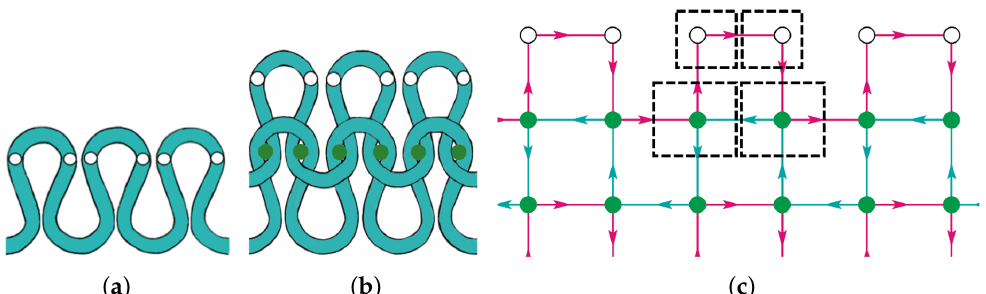
Figure 3. A Purl stitch is created by pulling a loop of yarn through a loop held from the previous row from front to back. ( a ) Row of loops. ( b ) Purl stitches produced from another row of stitches. ( c ) Topological representation. Note that an ACN produced by a Purl stitch is colored green, as compared to the gray disks of Knit-stitch-produced